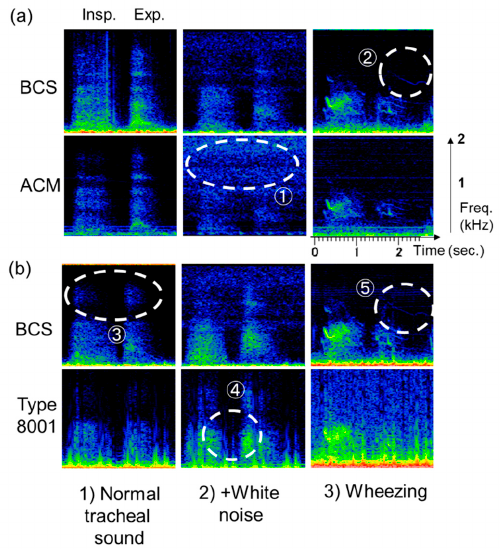
Figure 12. Respiratory sound detection in the sensors (representative cases). ( a ) BCS vs. ACM, ( b ) BCS vs. type 8001. Respiratory sounds observed included (1) normal breathing tracheal sound (left); (2) normal breathing tracheal sound in a noisy environment (center); and (3) wheezing sound from oral transmission (right).